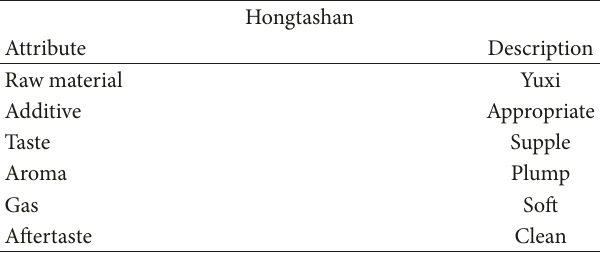
Table 1: Hongtashan product